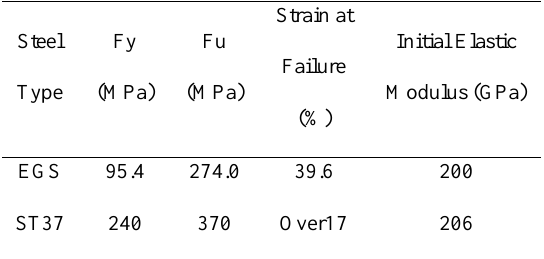
Table. 3. Properties of steel type (Susantha et al., 2005).